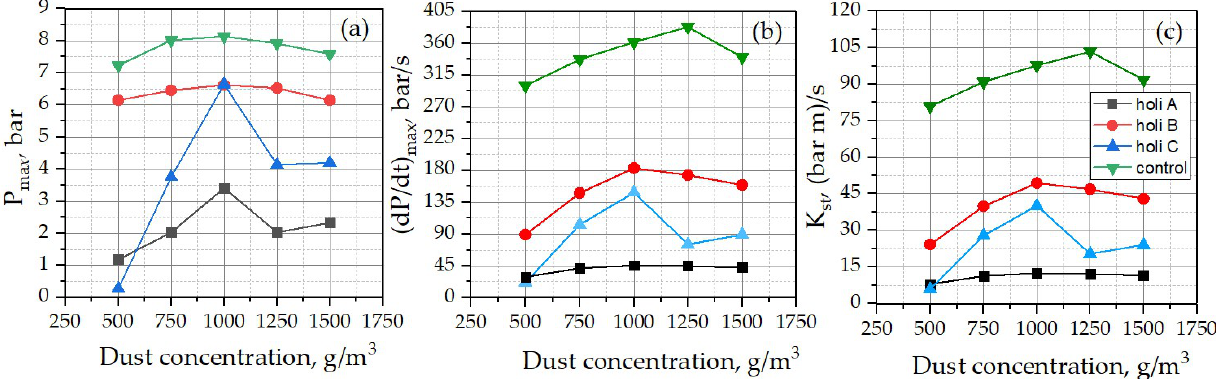
Figure 5. Dependence of the maximum explosion pressure ( a ), pressure increase rate (dP/dt)max ( b ) and explosion index K St ( c ) on the concentration of Holi A, B, and C powders and corn starch as a reference sample.